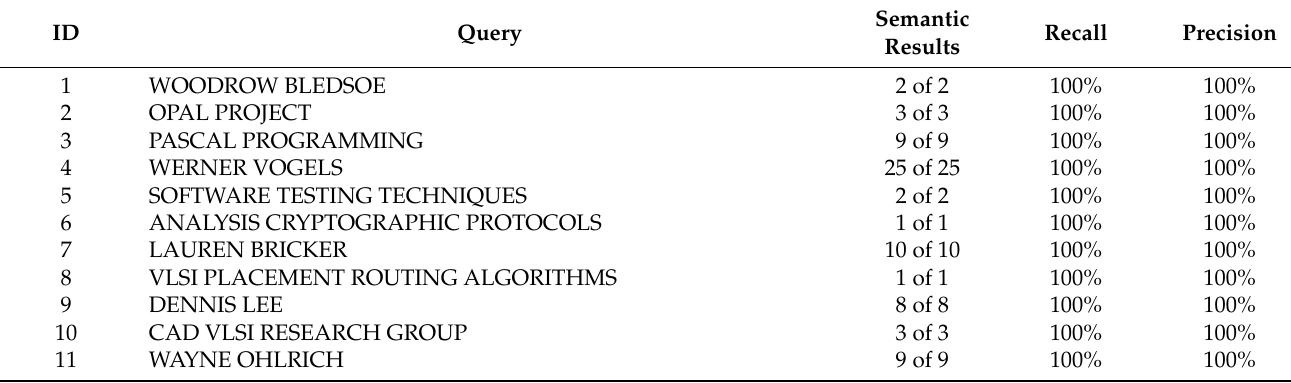
Table 10. Experimental results of 50